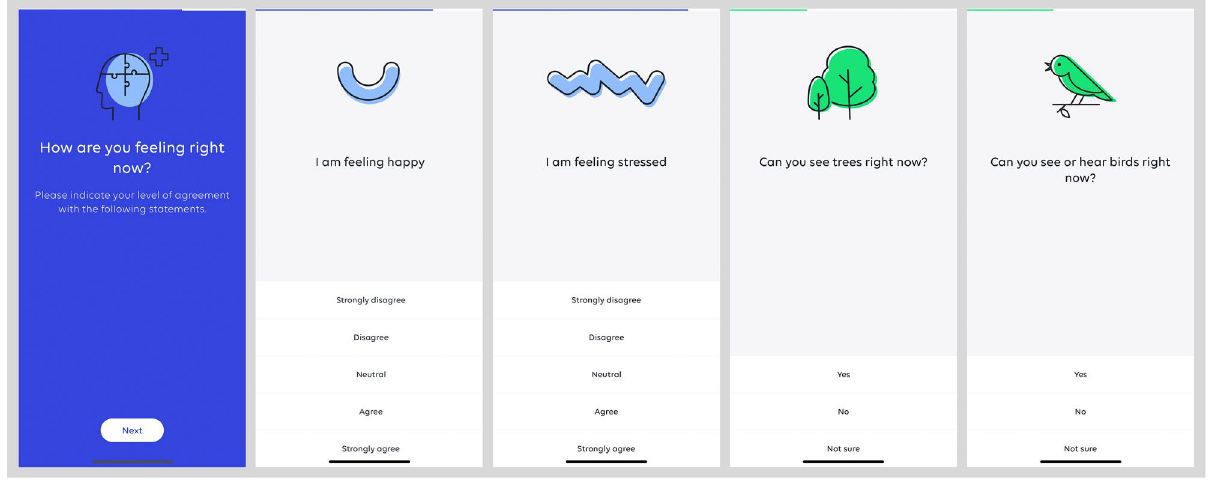
Figure 1. Screenshots of the Urban Mind app